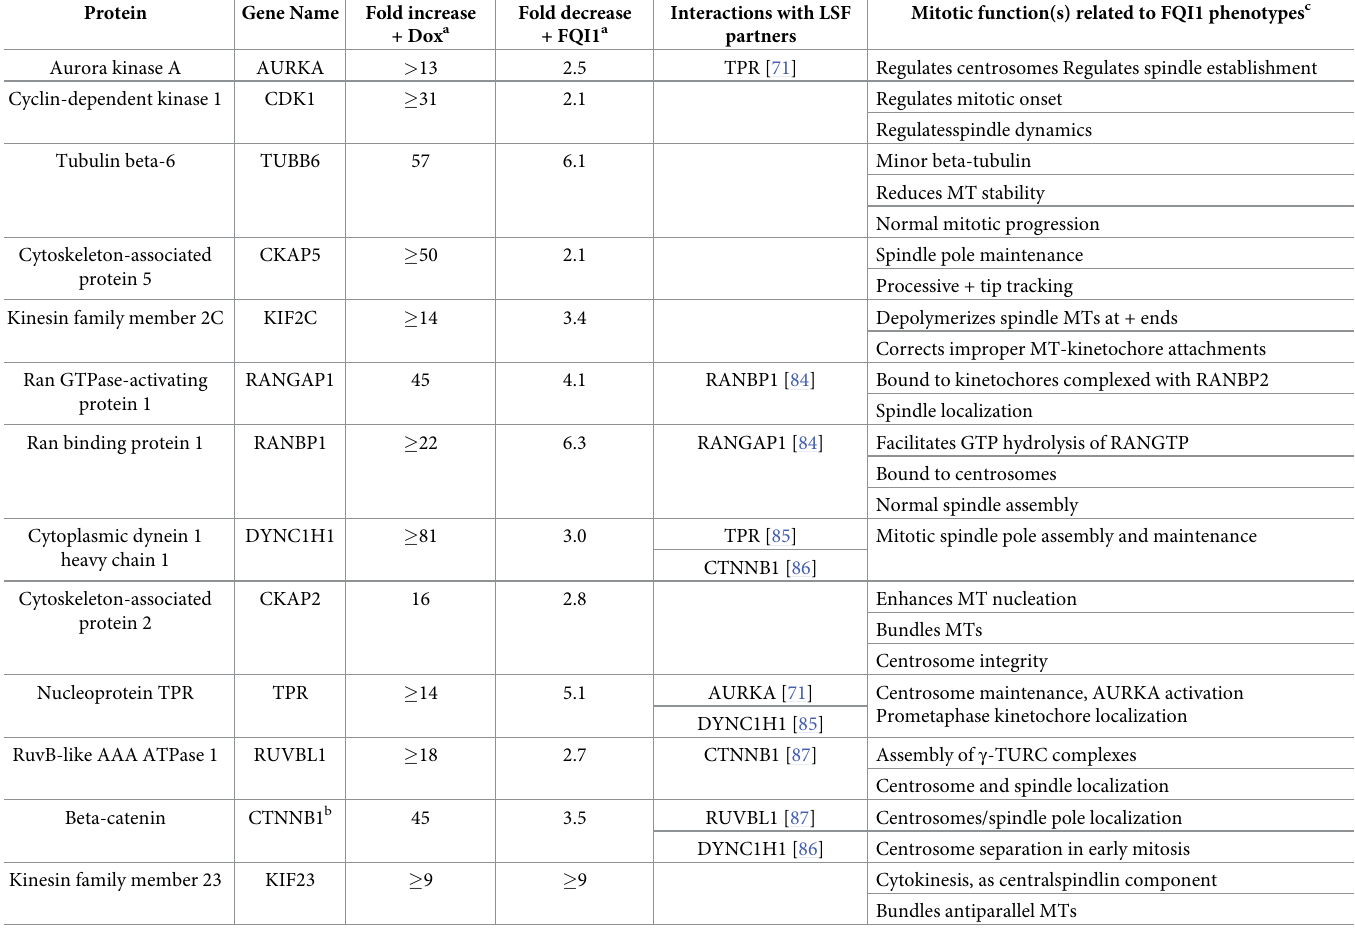
Table 1. FQI1-sensitive BioLSF-interacting proteins involved in mitotic spindle assembly, positioning, and dynamics or centrosome integrity, positioning, and function.